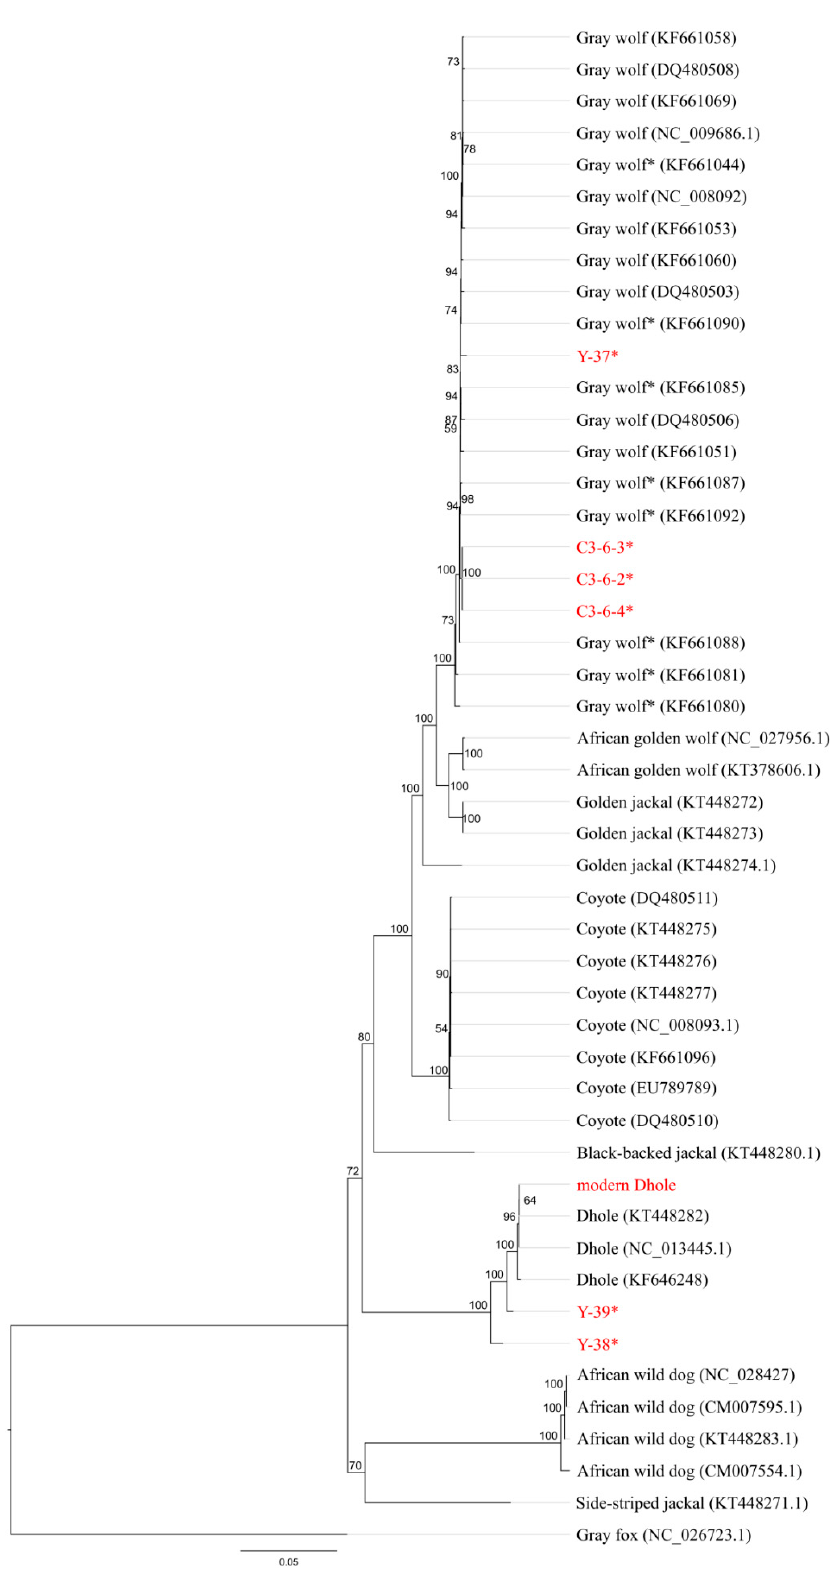
Figure 2. Maximum likelihood tree reconstructed with PHYML [57] using a 10,582 bp multiple sequence alignment (MSA) of 48 canid mitochondrial genomes as input and the TIM2 + I + G model with 100 bootstrap replicates. Support values are given next to nodes. Asterisks: ancient mitochondrial sequences. Red: samples of this study.